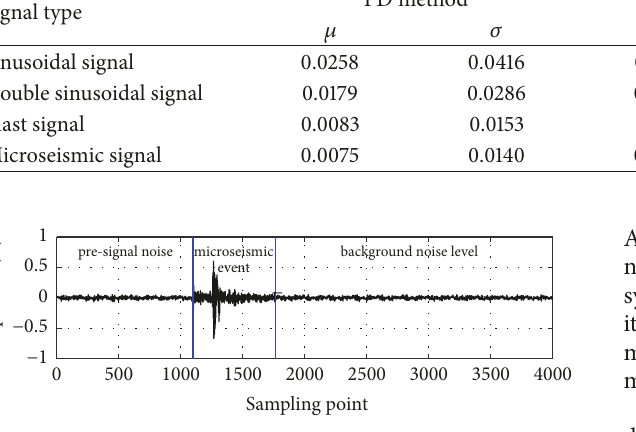
Figure 1: Classical microseismic event waveform.